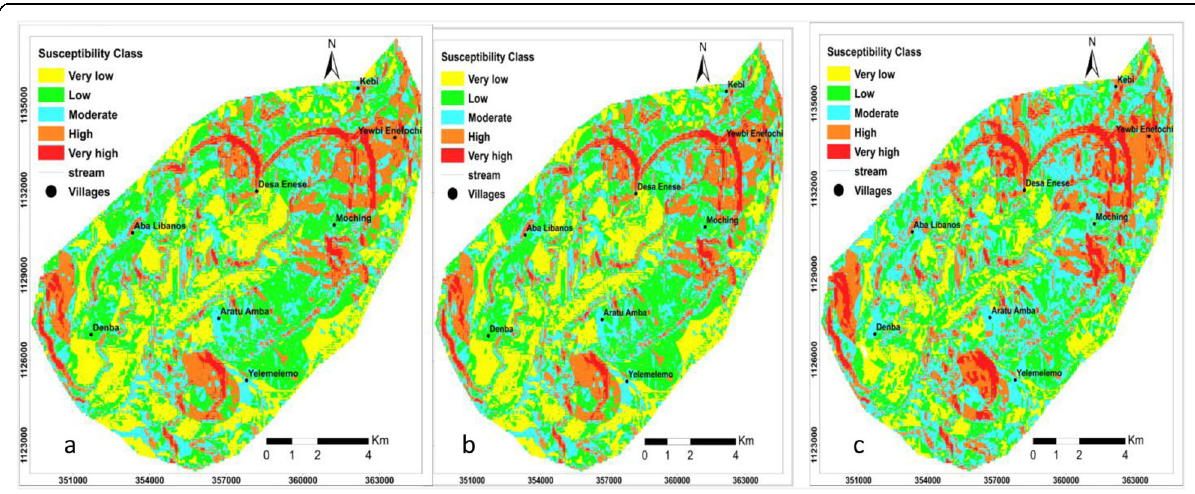
Fig. 4 Landslide Susceptibility Maps of ( a ) Frequency Ratio ( b ) Certainty Factor and ( c ) Information Value